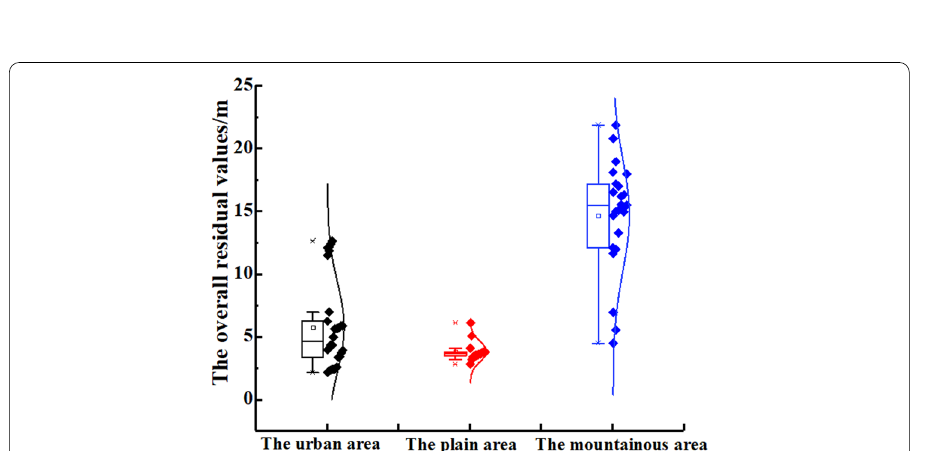
Fig. 4 Overall residual values of the Hongqi-1-H9 wide-range satellite imagery under three different terrains